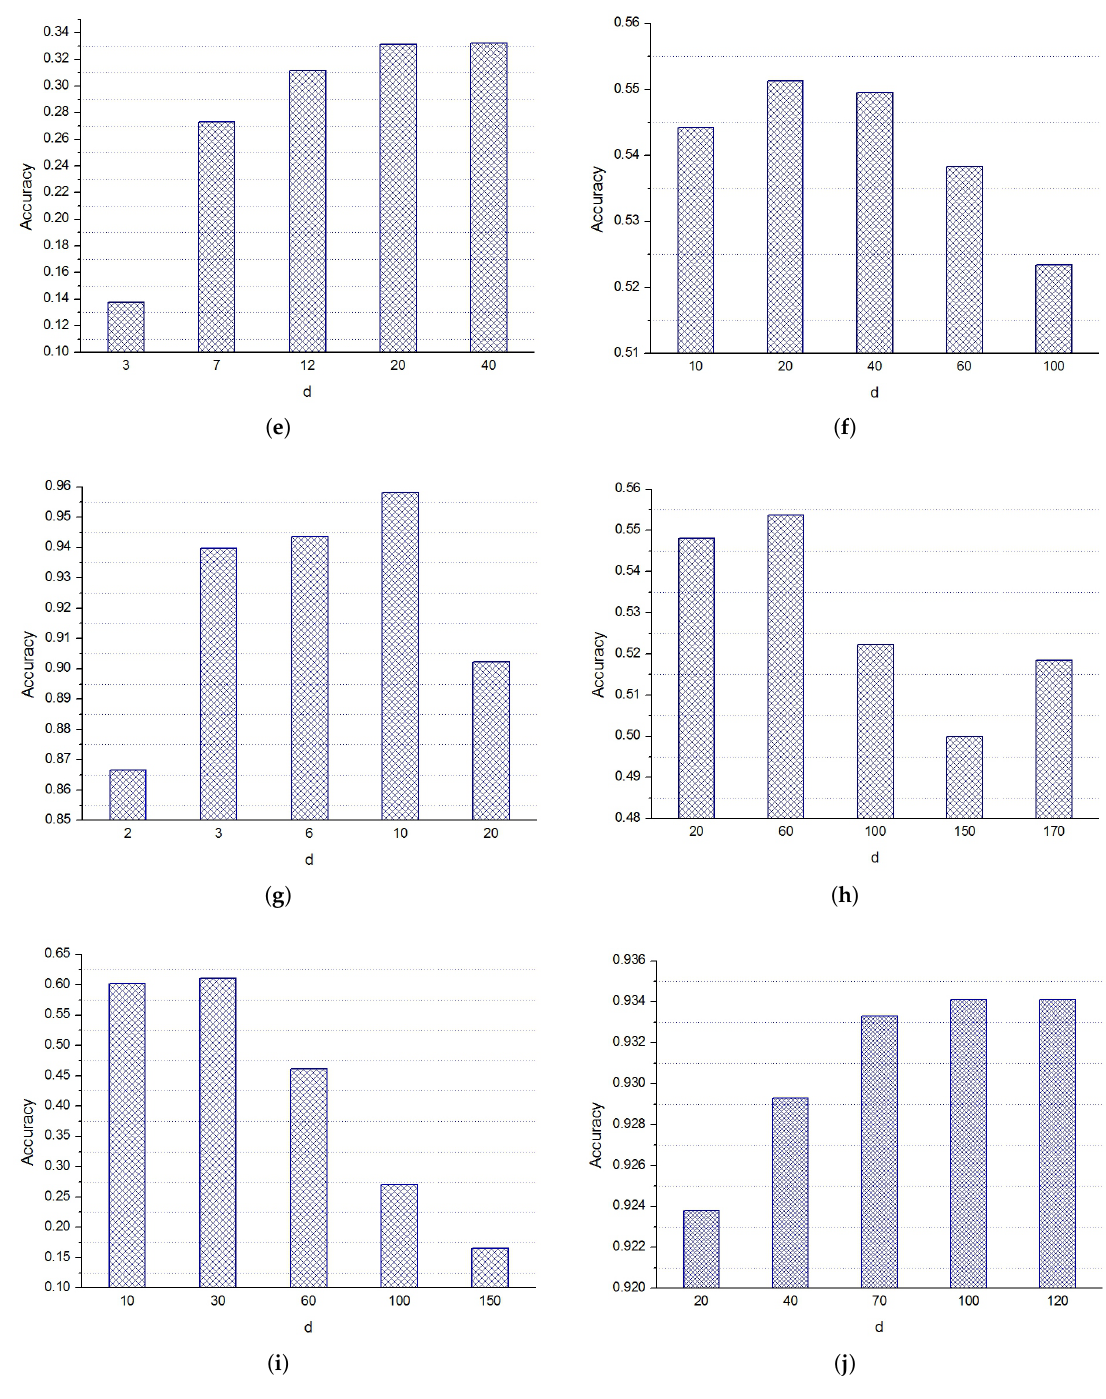
Figure 3. The test result CELM with different d values: ( a ) voice dataset; ( b ) waveform dataset; ( c ) bank dataset; ( d ) adult dataset; ( e ) letter dataset; ( f ) hyperplane dataset; ( g ) occupancy dataset; ( h ) hill dataset; ( i ) protein dataset; and ( j ) ozone dataset. Table 5. The accuracy standard deviation of CELM testing in Figure